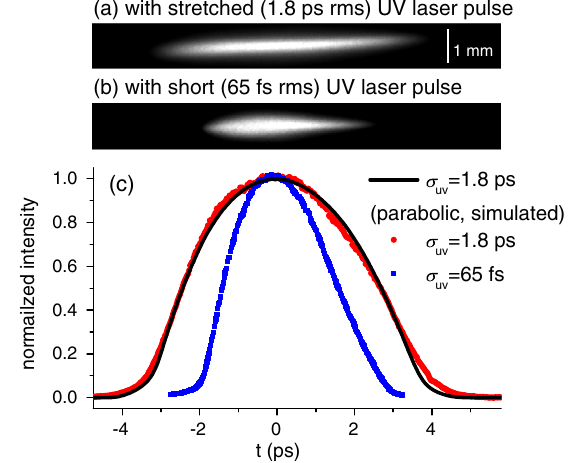
FIG. 4. Beam profiles on a transverse screen after streaked by an rf deflecting cavity when the UV laser pulse is (a) stretched to 1.8 ps rms, and (b) an ultrashort 65 fs rms distribution. Their projections onto the t ð z Þ axis are shown in (c) together with the GPT simulation result (black solid line) for an ideal 1.8 ps rms parabolic UV laser